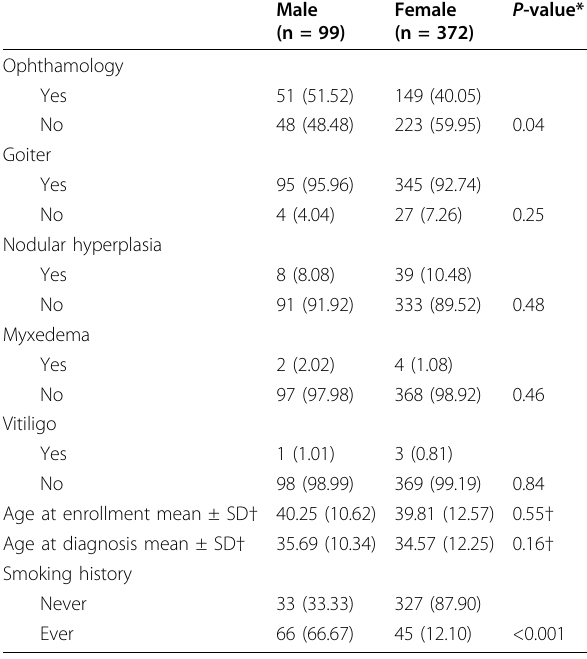
Table 1 Characters of Graves ’ Disease Patients between Male and